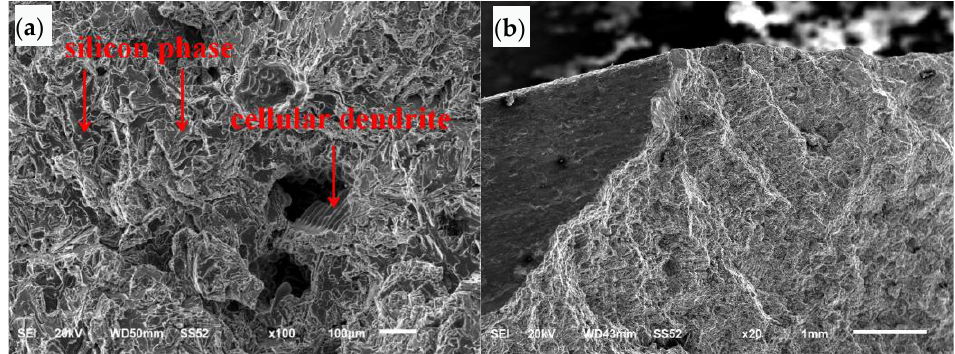
Figure 10. SEM morphology of the fracture initiation zone of the hinged plate: ( a ) low magnification, ( b ) high magnification.